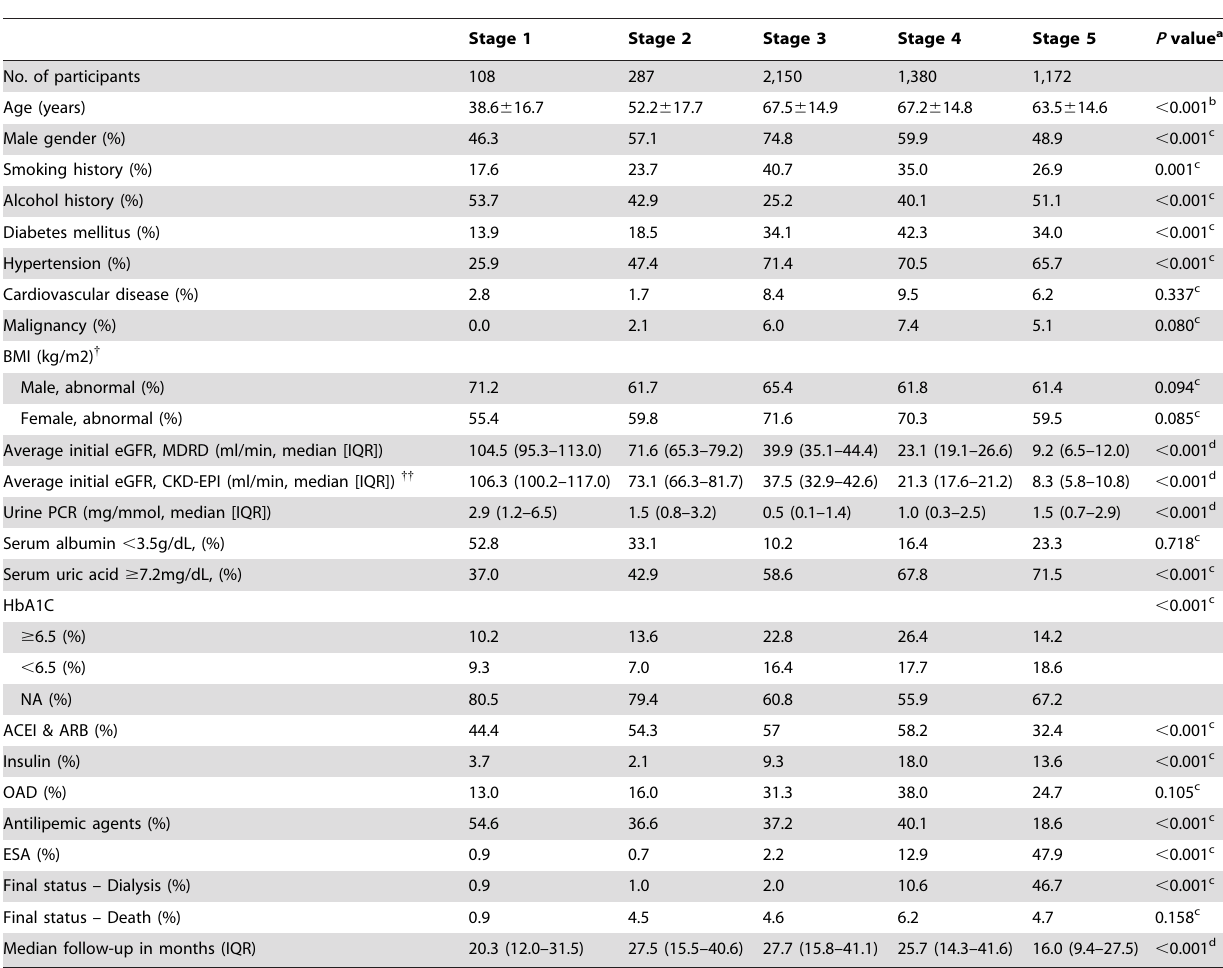
Table 1. Participants’ characteristics by different initial CKD